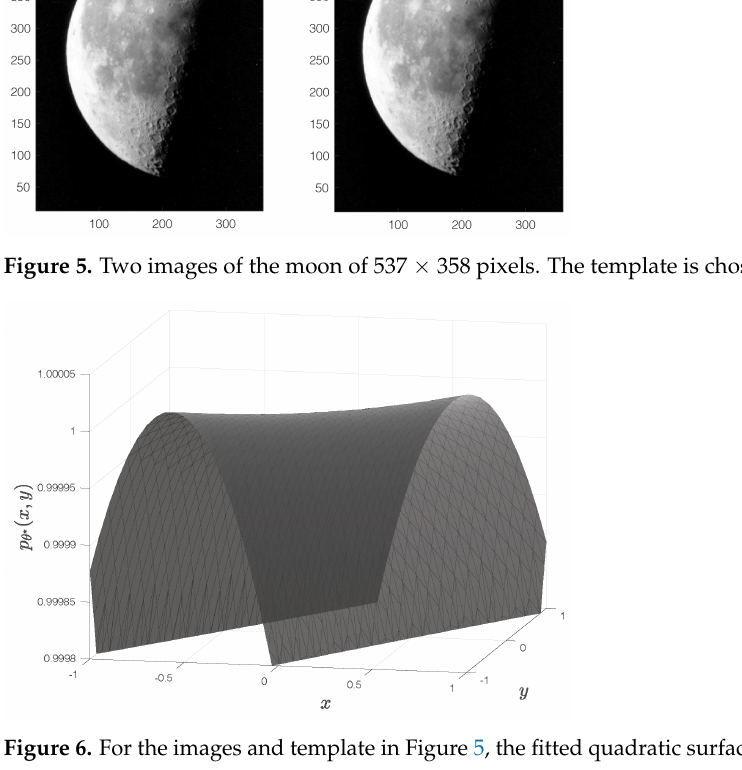
Figure 6. For the images and template in Figure 5, the fitted quadratic surface exhibits a saddle